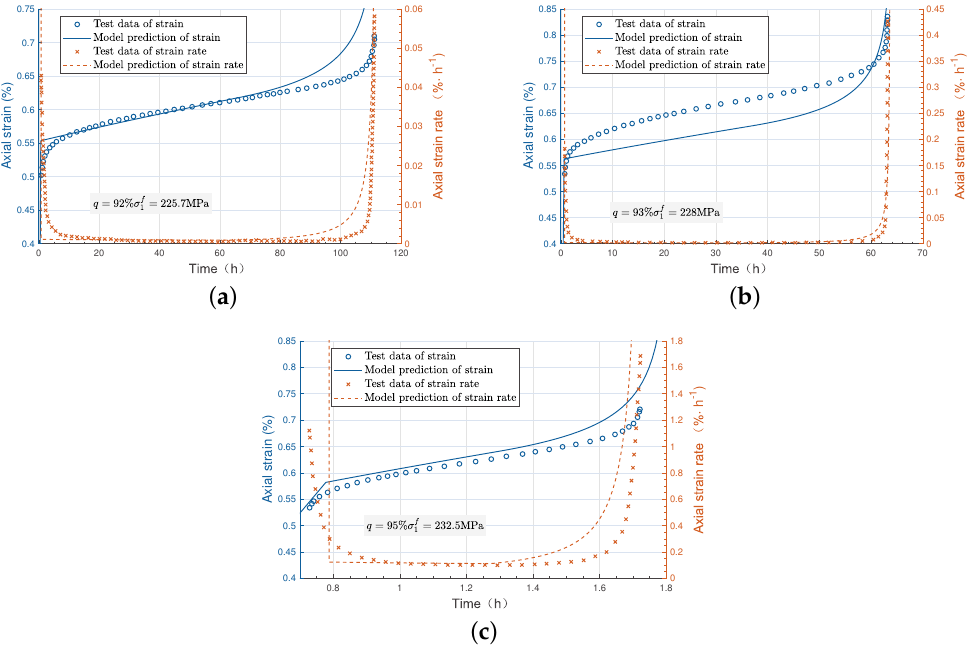
Figure 8. Analytical prediction of creep tests on Beishan granite with different initial deviatoric stress under confining pressure p c = 15 MPa. ( a ) q = 225.7 MPa; ( b ) q = 228 MPa; ( c ) q = 232.5